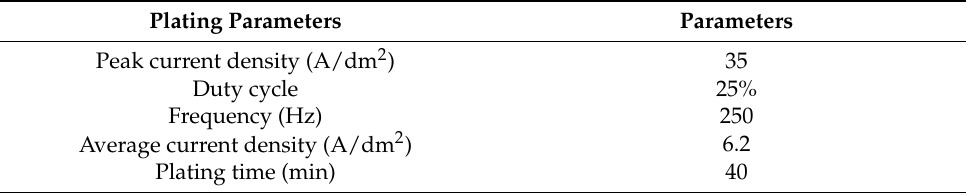
Table 2. Plating parameters used in the PED experiment. Plating